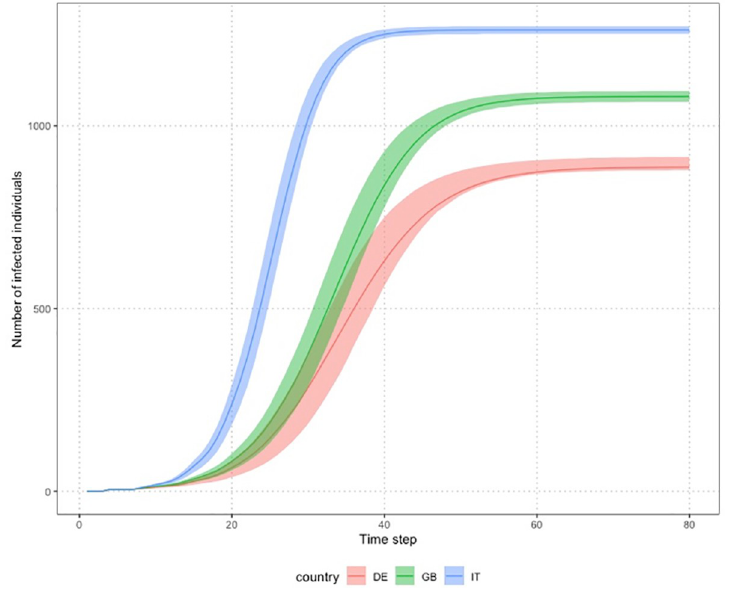
Fig 2. Average differences in the number of infected individuals over time across countries. Evolution of the average number of individuals infected over time. Dyadic contagion probability p = 0.05; “empirical” networks of 1,500 nodes, with the Italian population’s age structure, and with age mix and degree distribution calibrated on the same country in each panel, but differs across panels. Solid lines represent the average number of cases, the surface around represents the first and third quartile of the